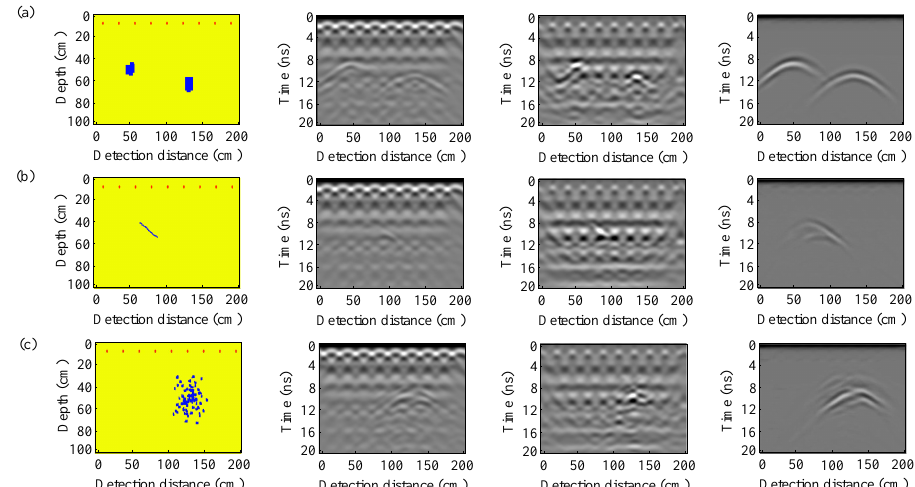
Figure 3. Dataset preparation: ( a ) synthetic model with void defects; ( b ) synthetic model with cracks; ( c ) synthetic model with untight concrete. The images of the first column are the permittivity maps of the synthetic models; the second column depicts the original B-scan images produced by FDTD simulations; the third and forth columns signify the migrated and deep-learning-processed GPR